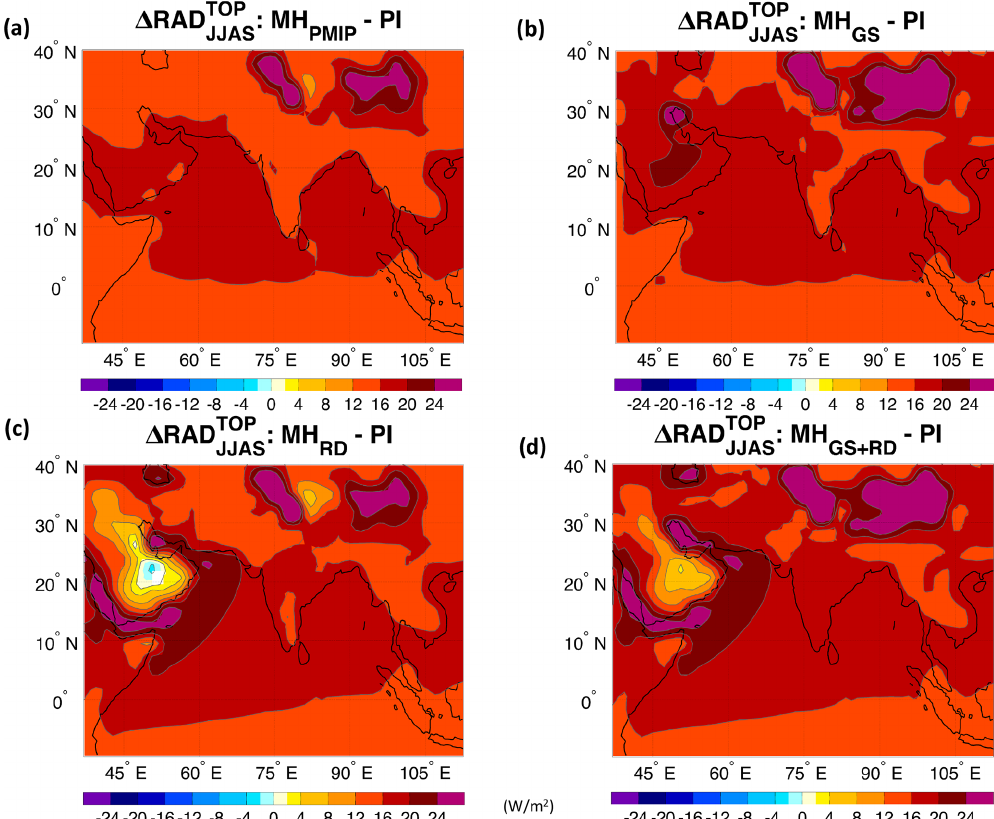
Figure 5. Changes in summer (JJAS) top-of-the-atmosphere shortwave radiation (RAD TOP ; W/m 2 ) for the (a) mid-Holocene-only orbital forcing (MH PMIP ); (b) the Sahara greening (MH GS ); (c) the dust-only reduction (MH RD ); and (d) the Sahara greening and dust reduction (MH GS + RD ) experiments relative to the PI reference simulation. The contour lines follow the color-bar scale (the 0 lines are omitted for clarity). Only differences significant at the 95% confidence level using the Student t test are